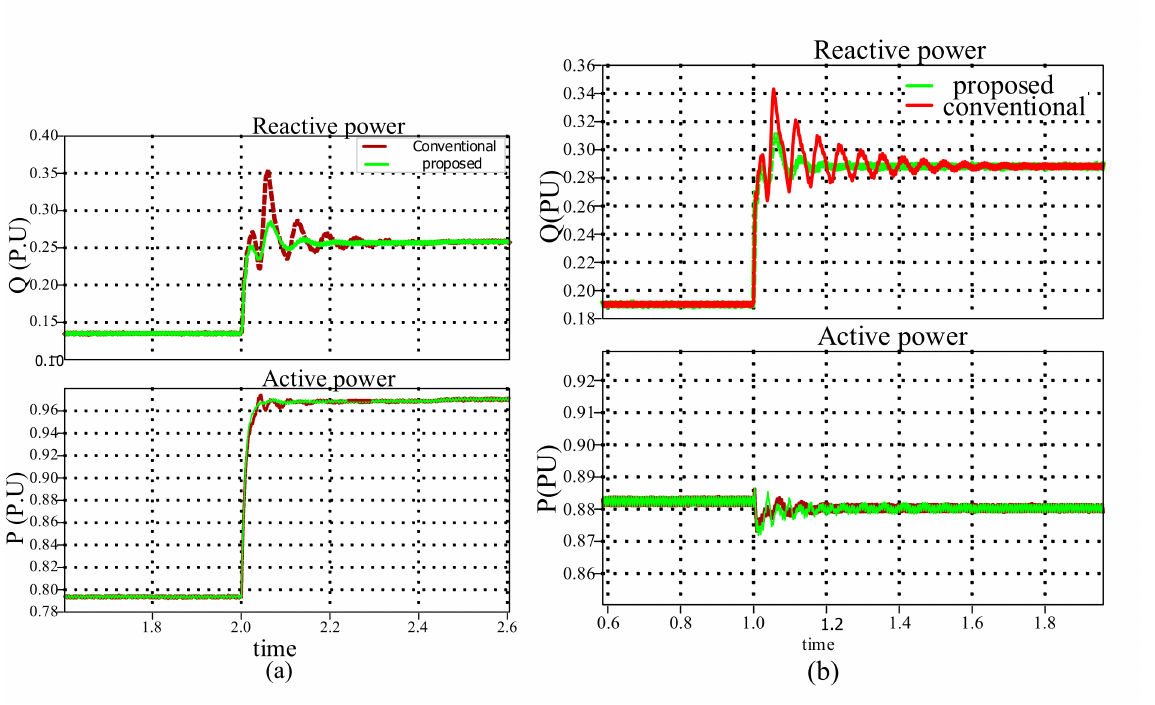
Figure 17. Reactive and active power: ( a ) step change in solar insolation and ( b ) grid inductor